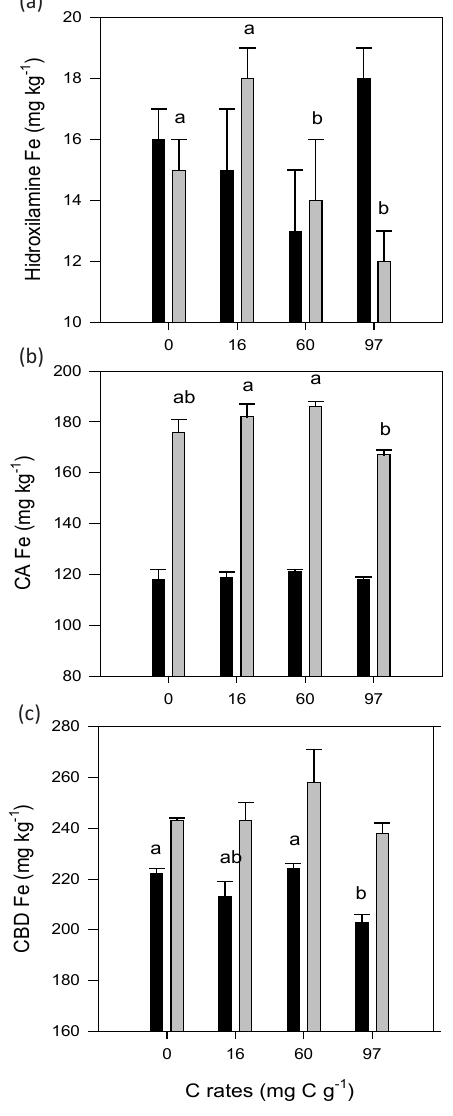
Fig. 3. Effect of the different rate of Fe-HS on Fe extractable with hydroxylamine in the growing medium (a), on Fe extractable with citrate ascorbate (CA-Fe) in the growing medium (b), and on Fe extractable with citrate bicarbonate dithionite (CBD-Fe) in the growing medium (c) of lupin plants (black columns) and wheat plants (grey columns). One- way ANOVA was performed for each plant independently. Means with different letter were significantly different as per LSD test at p < 0.05. Error bars indicate one standard